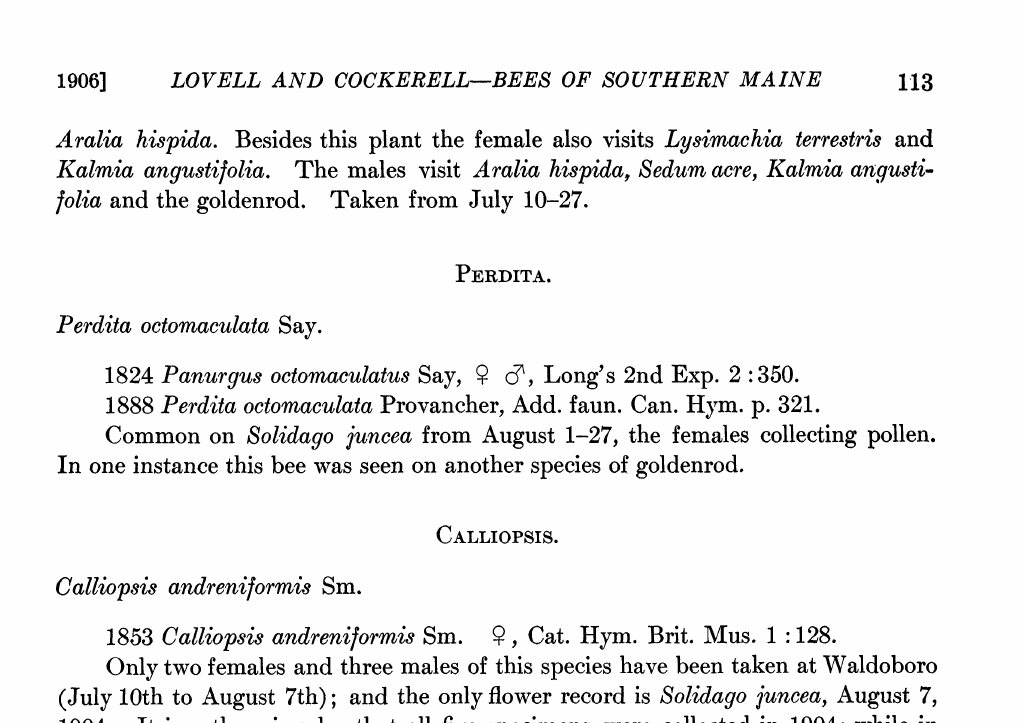
table in Trans. Am. Ent. Soc., Dee. 1898, p. 197, this runs to 35, and cannot be separated from P. asteris